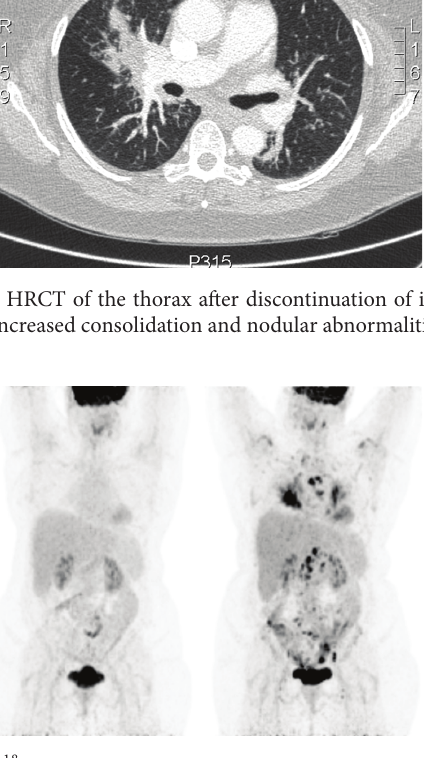
Figure 3: 18 F-FDG-PET scan monitoring sarcoidosis activity level. In the left frame is shown the 18 F-FDG-PET scan during treatment with infliximab and in the right frame the 18 F-FDG-PET scan after discontinuation of infliximab revealing reactivation of sarcoidosis as black spots in lungs and lymph